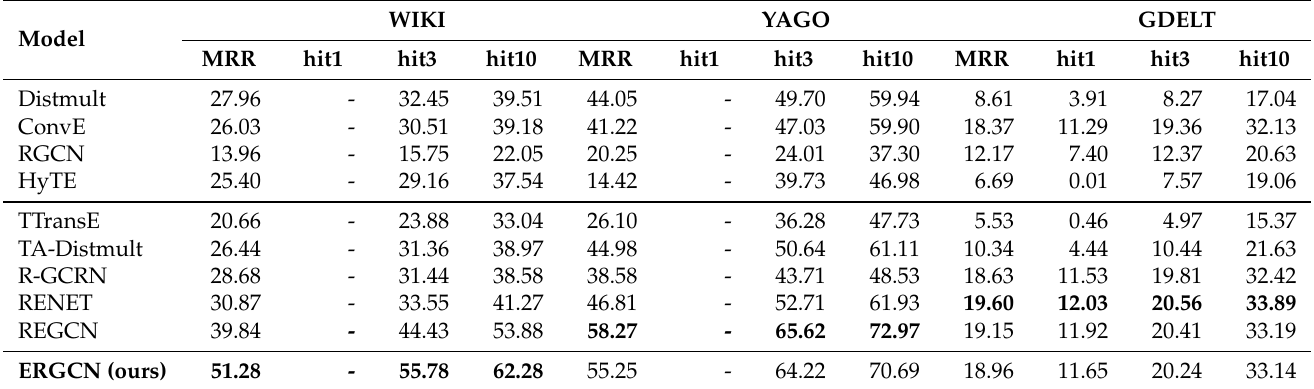
Table 3. Experimental results of entity prediction on WIKI, YAGO and GDELT in raw metrics. WIKI